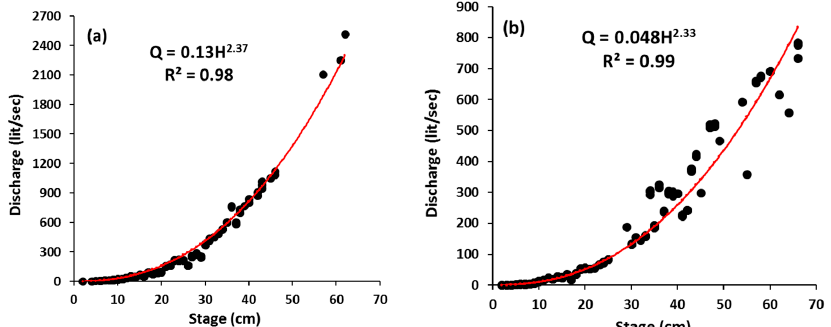
Figure A3. Stage discharge relationship for weir-1 ( a ) and weir-2 ( b ) where Q is discharge in lit/sec and H is the stage height in cm.